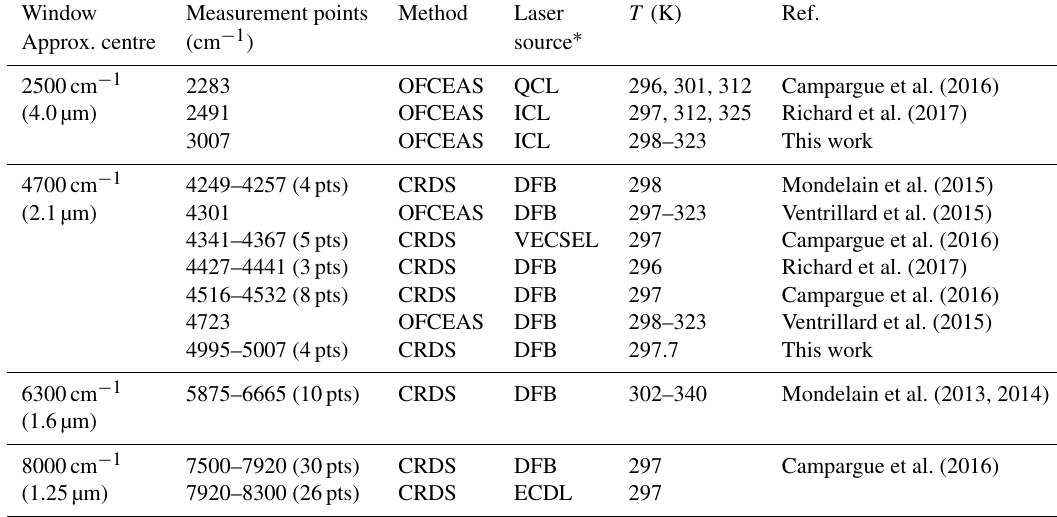
Table 2. Summary of the self-continuum retrievals of water vapour performed by CRDS and OFCEAS. Window Measurement points Method Laser T (K) Ref.